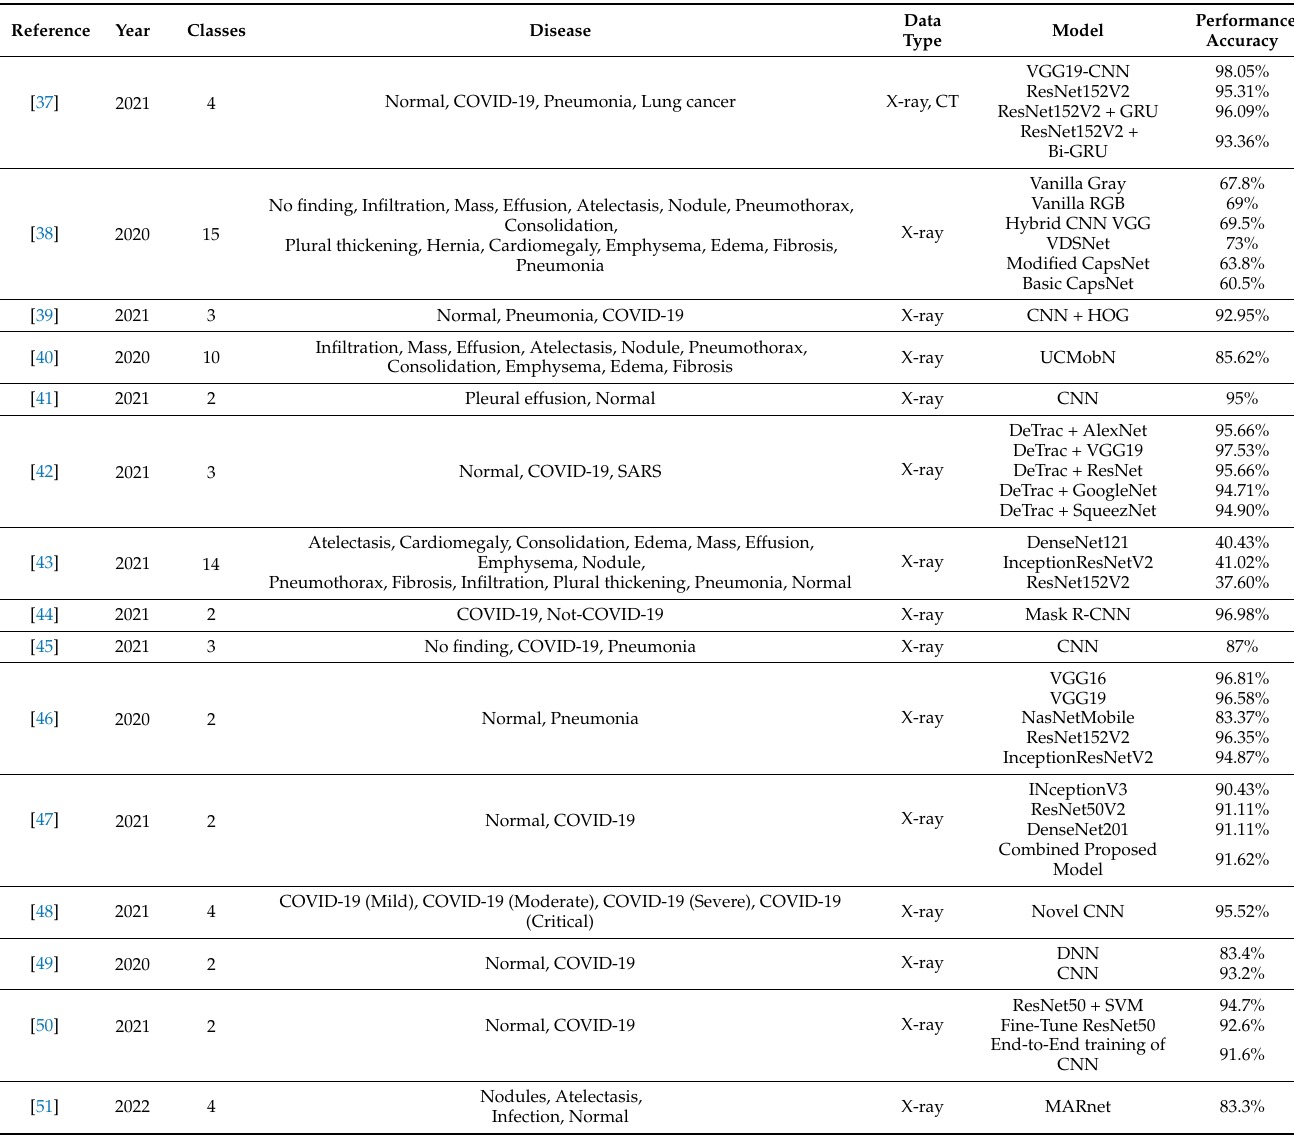
Table 1. A summary of related studies on lung disease